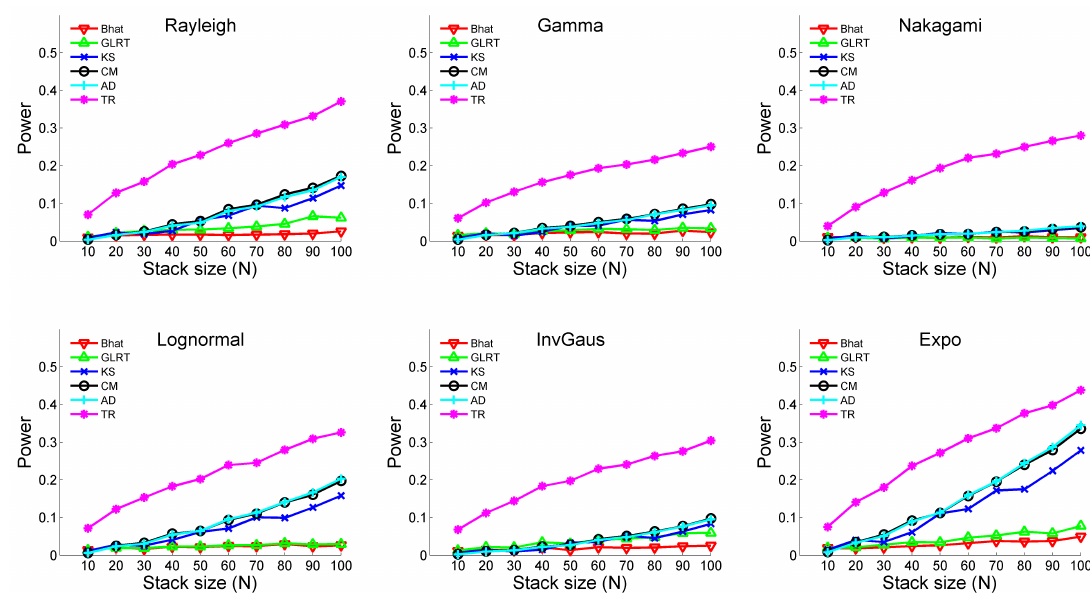
Figure 3. The power of hypothesis tests in case